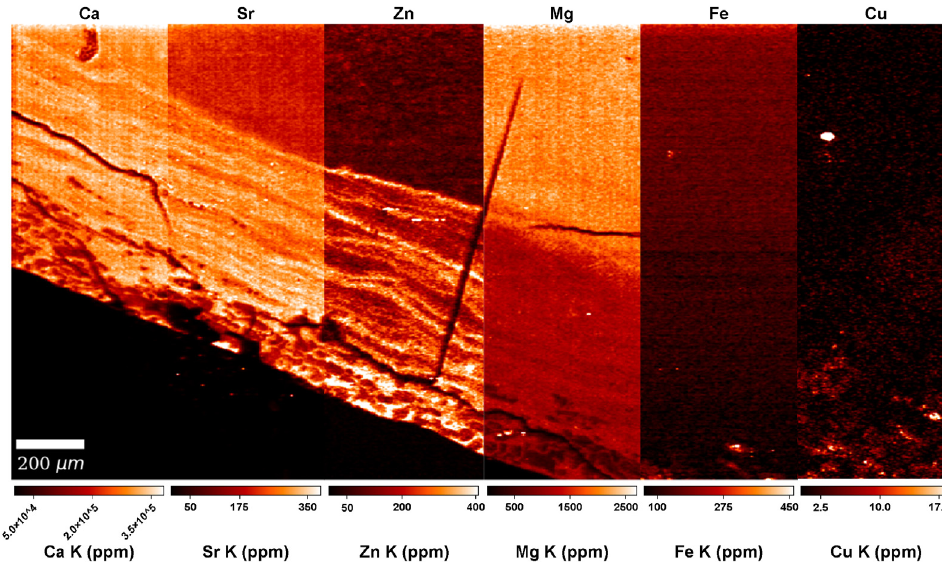
Figure 4. Calibrated LA-ICP-TOFMS high-resolution (2 µm) maps of the cellular cementum of Næstved 211C (See File S3) depicting the distributions of elements potentially impacted in leprosy, i.e., Ca, Zn, Mg, Fe, and Cu, as well as Sr. Note the weak signal in the Mg map, showing the same enrichment and depletion events as in the Ca, Zn, and Sr maps, with a positive, although weak, correlation to the Mg variations (rho = 0.45 for Ca, rho = 0.19 for Zn, and rho = 0.27 for Sr). Graphic programs used: Adobe Photoshop CS6 and Adobe Illustrator CS6.